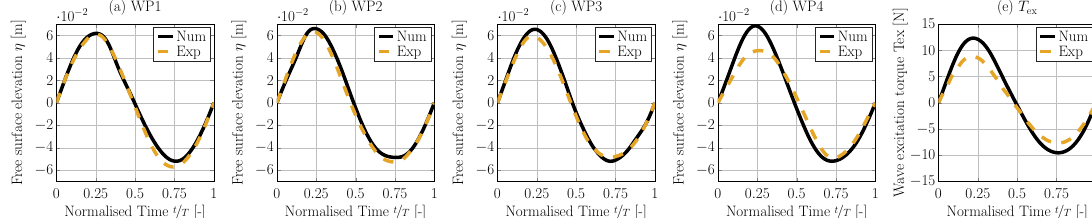
Figure 11. Phase-averaged free surface elevation, measured at wave probes WP1–WP4 ( a – d ), and wave excitation torque ( e ) for wave